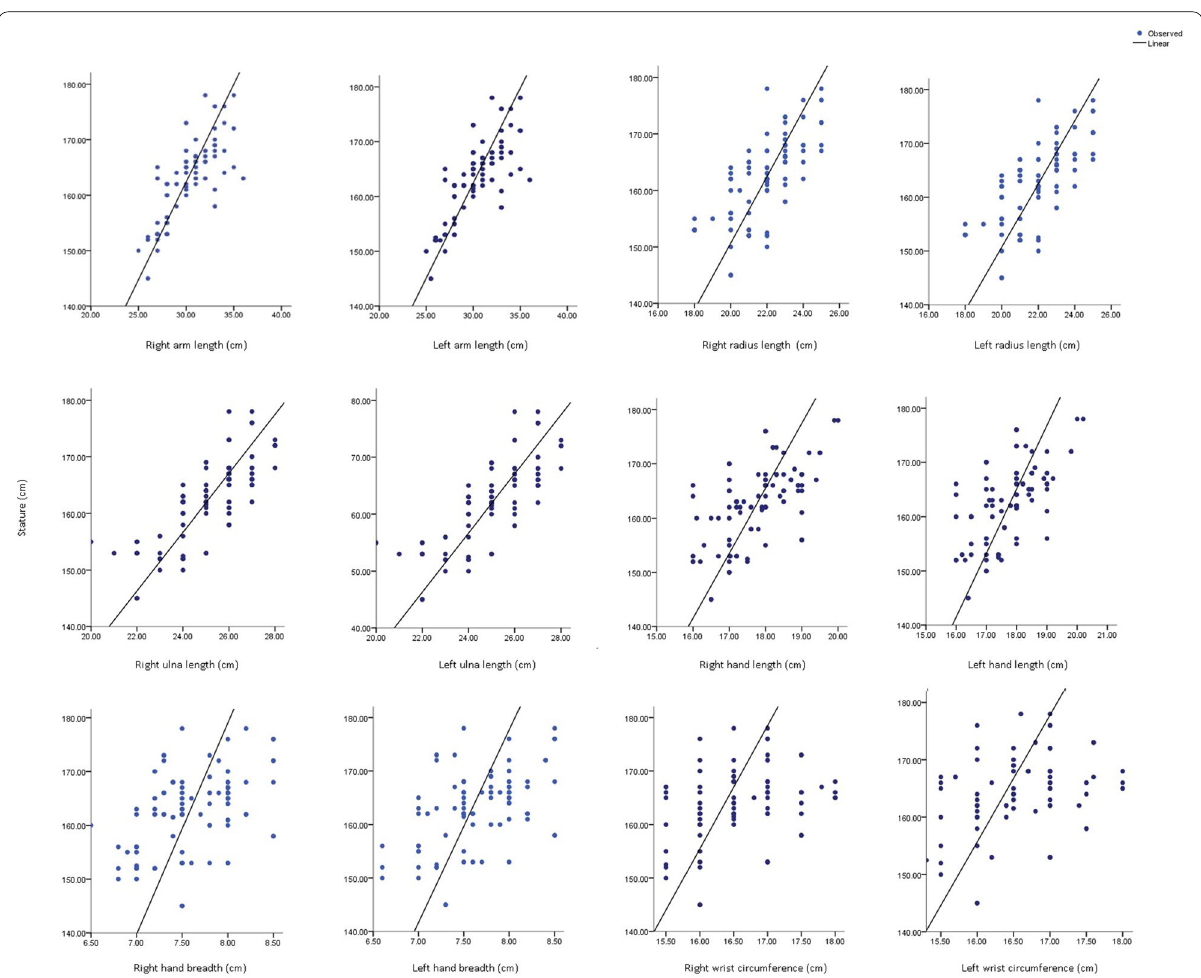
Fig. 1 Scatter diagram with regression analysis showing association of the stature with lengths of the right and left arm, radius, ulna, and hand; breadths of the right and left hand; and right and left wrist